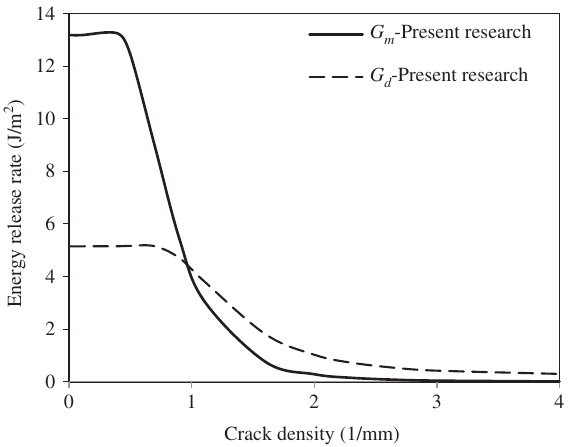
Figure 7: Crack density vs. energy release rate for [0/90 = 100 MPa. epoxy laminate under σ 1